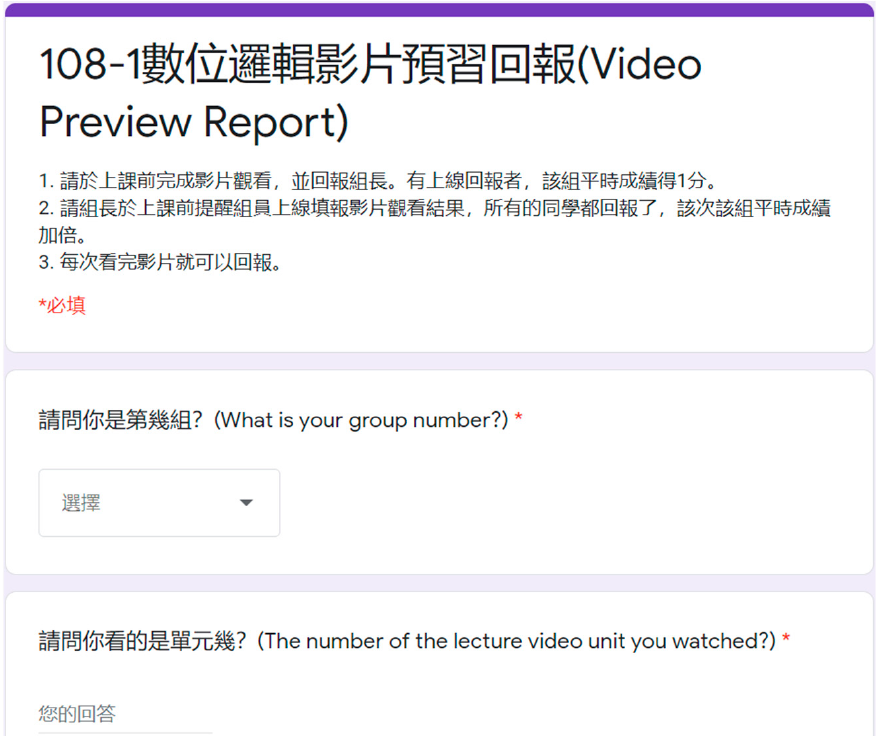
Figure 6. Video Preview Report: students record the date and time they watched the video, the group number, and the names of participating members in the form.